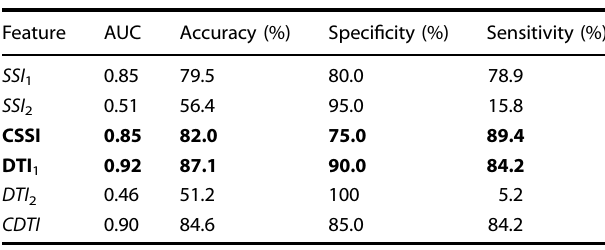
Table 4. Classi fi cation accuracy between PD and PSP.